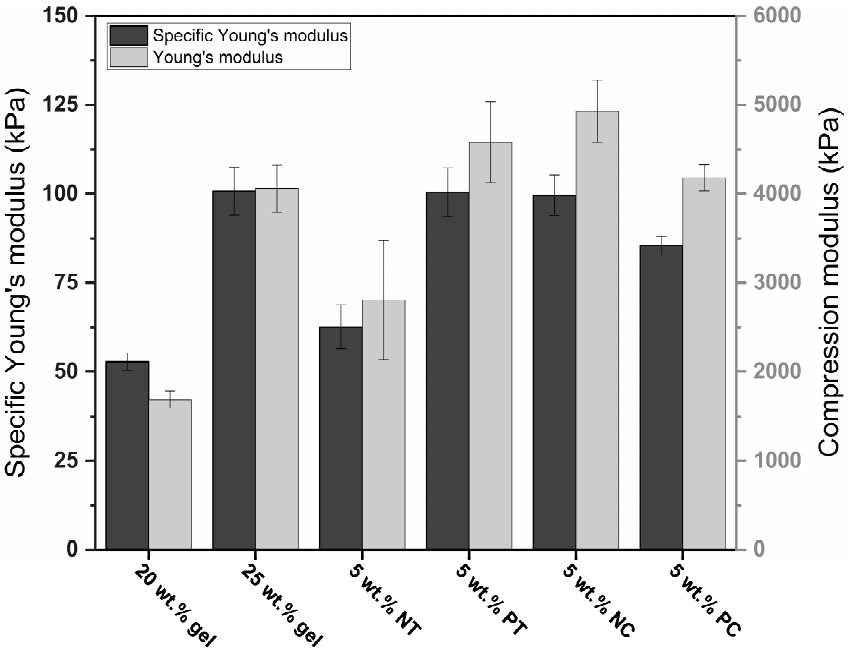
Figure 7. Comparison of the specific modulus and compression modulus of the gelatin and gelatin– starch foams.